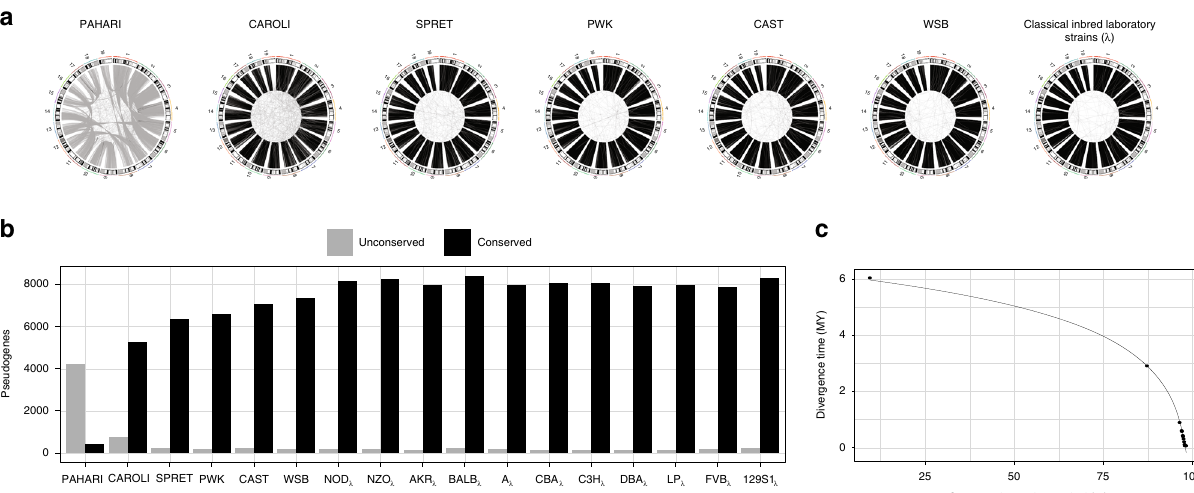
Fig. 5 Pseudogene loci conservation across mouse strains. a CIRCOS-like plots showing the conservation of the pseudogene genomic loci between each mouse strain and the laboratory reference strain C57BL/6NJ. Grey lines indicate a change of the genomic locus between the two strains and connect two different genomic locations (e.g., a pseudogene located on chr7 in C57BL/6NJ and chr1 in M. pahari ). Black lines indicate the conservation of the pseudogene locus. b The number of pseudogenes that are preserved or changed their loci between each strain/species and the laboratory reference strain. Associated data is available in Supplementary Table 6. c Strain speciation times as a function of percentage of conserved pseudogene loci between each strain/species and the laboratory reference, fi tted by an inverse logarithmic